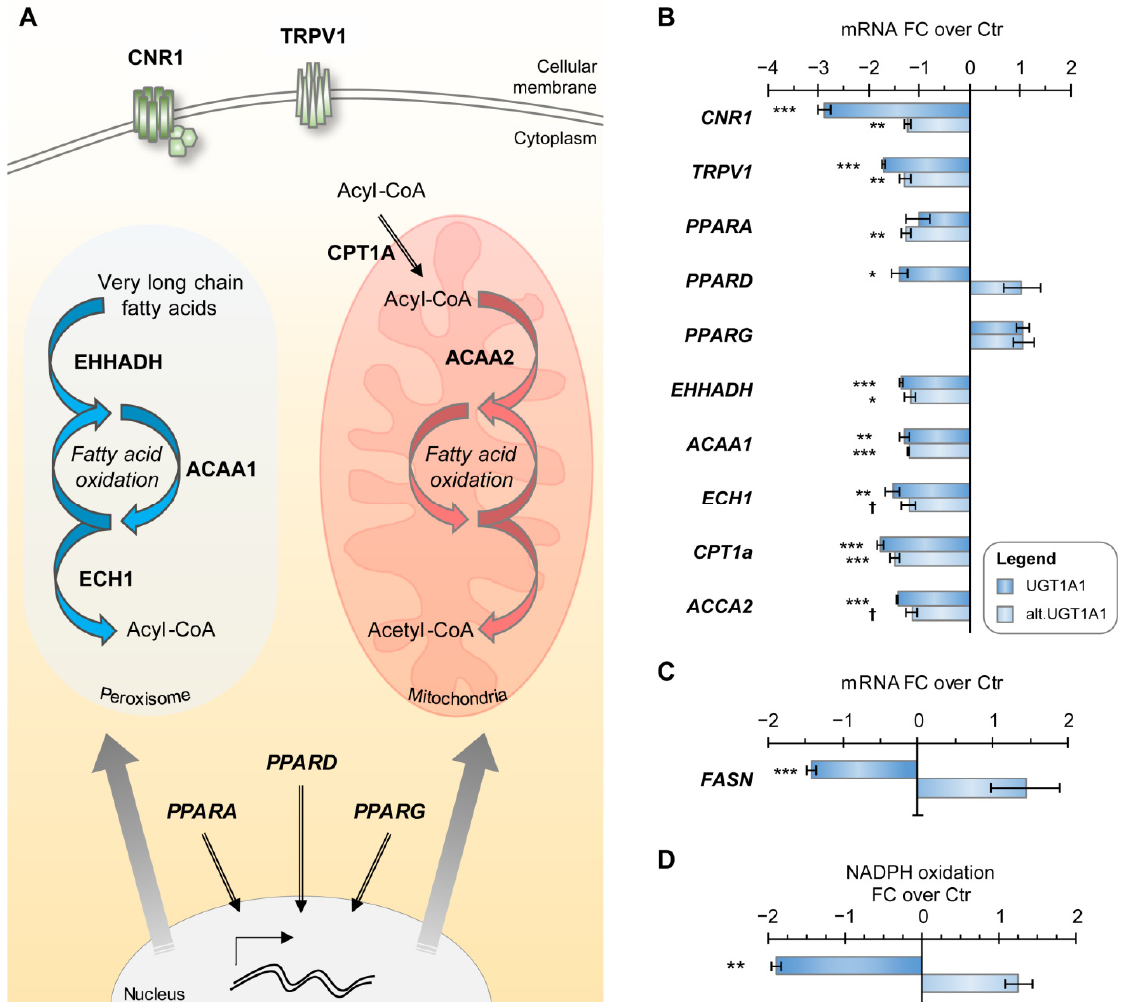
Figure 5. The cannabinoid system is downregulated in cells expressing UGT1A1 enzyme and its alt. protein. ( A ) Scheme of the endocannabinoid system in HEK293 cells, including cannabinoid receptors (CNR1, TRPV1), peroxisome proliferator-activated receptors (PPARs) and some PPAR targets. ( B ) Gene expression of the endocannabinoid system in HEK293 cells expressing UGT1A1 enzyme and alt. UGT1A1. Expression of most genes is perturbed in both cell models and preferentially reduced in UGT1A1 enzyme-expressing cells. Cells expressing the UGT1A1 enzyme have lower fatty-acid synthase (FASN) ( C ) expression and ( D ) activity than control cells, as detected by an assay measuring NADPH oxidation upon malonyl-CoA addition. EHHADH, Enoyl-CoA Hydratase And 3-Hydroxyacyl CoA Dehydrogenase; ACAA, Acetyl-CoA Acyltransferase; ECH1, Enoyl-CoA Hydratase 1; CPT1A, Carnitine Palmitoyltransferase 1A. *** p < 0.001, ** p < 0.01, * p < 0.05, † p < 0.1.